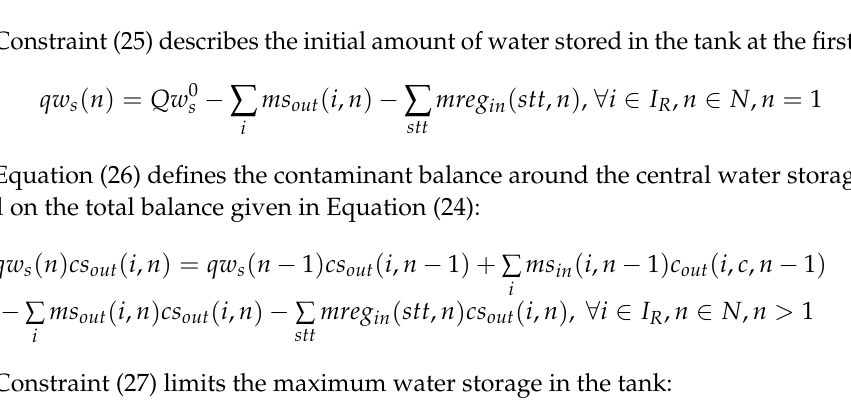
Figure 2. Superstructure for water mass balance in central water storage tank.